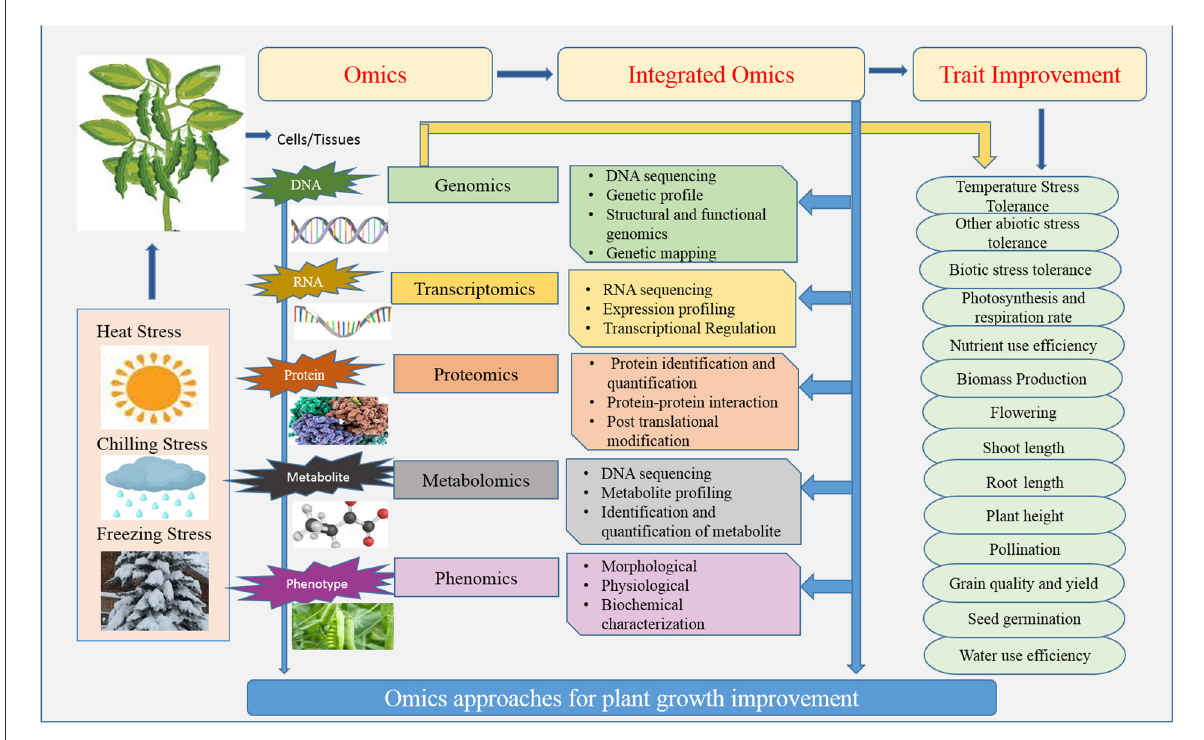
FIGURE2 Schematic visualizing the contribution of OMIC’s approaches for legume plant